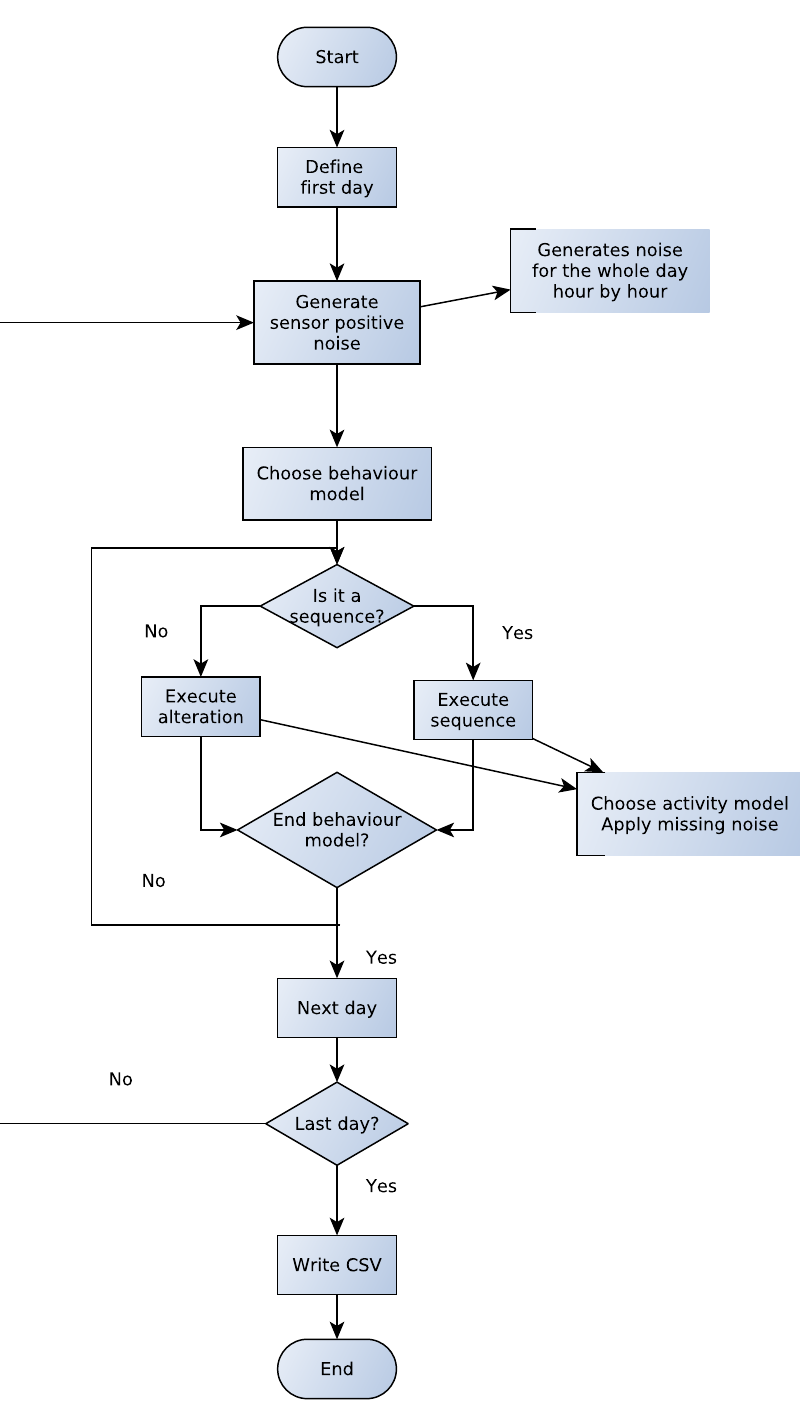
Figure 8. A flowchart of the simulation loop of the synthetic dataset